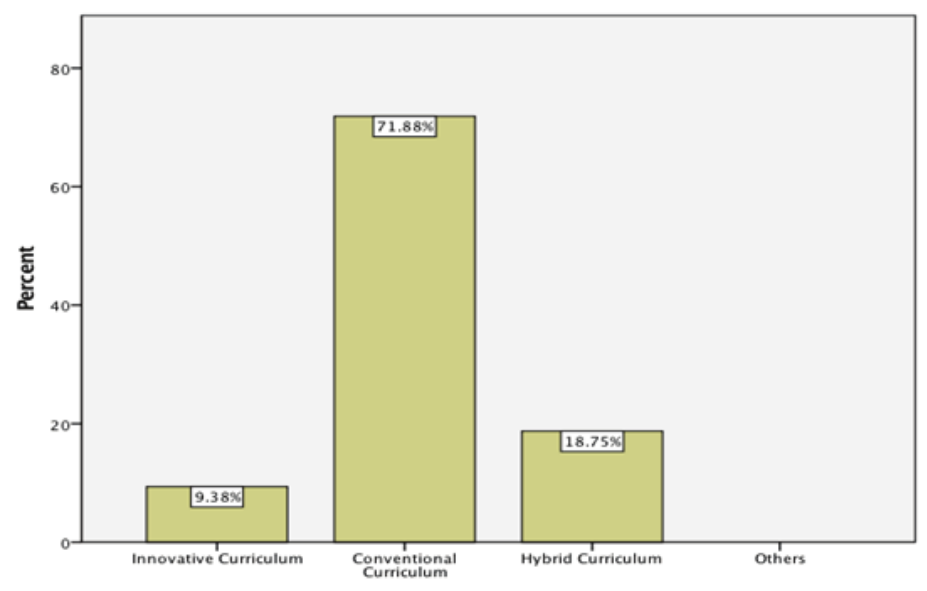
Figure 1: Mode of receiving undergraduate studies.